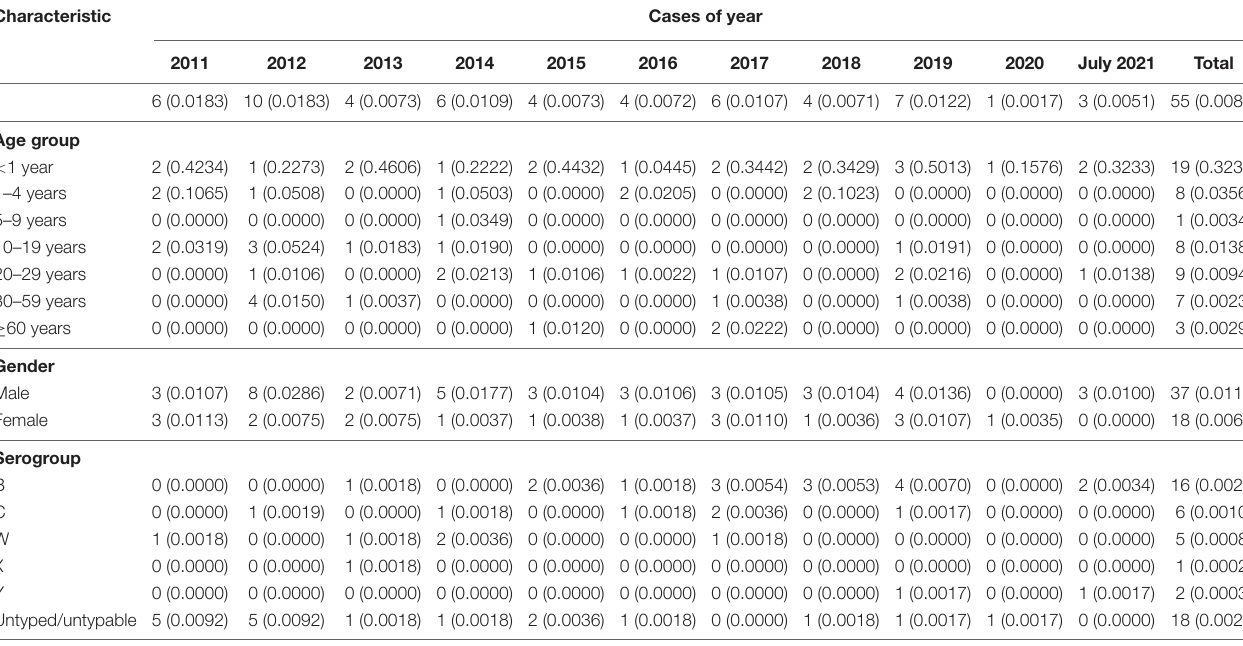
TABLE 1 | Cases of meningococcal disease by year, age, gender, and serogroup during 2011–July 2021 in Zhejiang Province, China.